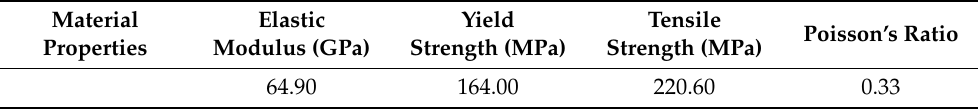
Table 4. Number of fatigue life cycle for the welded